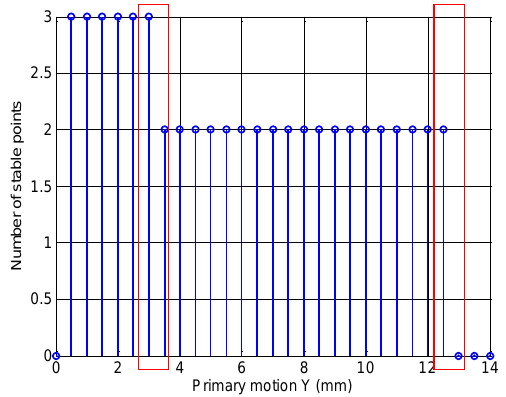
Figure 5. Number of stable rotational points under the specified primary motion.